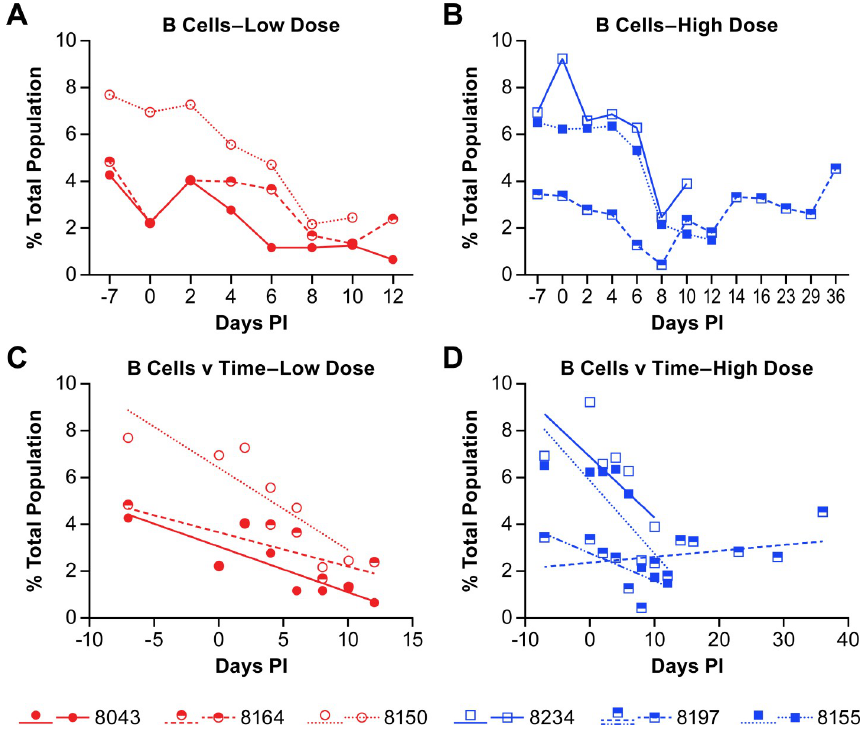
Fig 4. Changes in B cell populations in animals infected with NiV. The percent of B cells in the total population of analyzed cells is presented for individual animals in the low dose group (A and C) and the high dose group (B and D). Linear regression analyses (C and D) to determine the rate of change over the course of acute disease for all animals and convalescence for the animal that survived infection. The r-values for the linear regression analyses are provided in S1 Table. Linear regression analysis was performed on samples from all animals through day 12 (acute phase) with additional analysis of the surviving animal over the entire course of disease (blue dashed line).